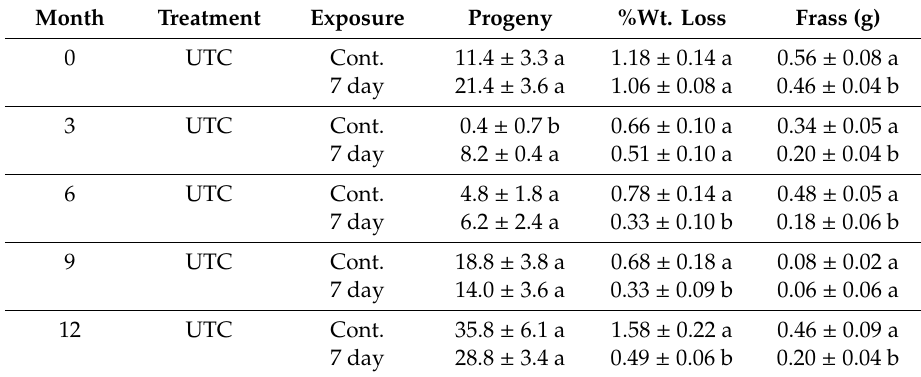
Table 9. Number of F 1 adult progeny, % of sample weight loss due to insect feeding, and feeding damage (frass) (mean ± SE for all) from exposure of ten mixed-sex parental adult T. castaneum exposed continuously for about 8 weeks (Cont.) on ~80 g of untreated corn (UTC), or parental adults were removed after 1 week and samples were held for an additional 8 weeks (7 day). No progeny development on corn treated with either rate of Diacon IGR + or the Gravista formulation, no overall ANOVA done, only comparison between the two parental exposure regimes. Data are separated by month, bioassays were done at 1 day (month 0), and 3, 6, 9, and 12 months after treatment 1 . Month Treatment Exposure Progeny %Wt. Loss Frass (g) 0 UTC Cont. 11.4 ± 3.3 a 1.18 ± 0.14 a 0.56 ± 0.08 a 7 day 21.4 ± 3.6 a 1.06 ± 0.08 a 0.46 ± 0.04 b 3 UTC Cont. 0.4 ± 0.7 b 0.66 ± 0.10 a 0.34 ± 0.05 a 7 day 8.2 ± 0.4 a 0.51 ± 0.10 a 0.20 ± 0.04 b 6 UTC Cont. 4.8 ± 1.8 a 0.78 ± 0.14 a 0.48 ± 0.05 a 7 day 6.2 ± 2.4 a 0.33 ± 0.10 b 0.18 ± 0.06 b 9 UTC Cont. 18.8 ± 3.8 a 0.68 ± 0.18 a 0.08 ± 0.02 a 7 day 14.0 ± 3.6 a 0.33 ± 0.09 b 0.06 ± 0.06 a 12 UTC Cont. 35.8 ± 6.1 a 1.58 ± 0.22 a 0.46 ± 0.09 a 7 day 28.8 ± 3.4 a 0.49 ± 0.06 b 0.20 ± 0.04